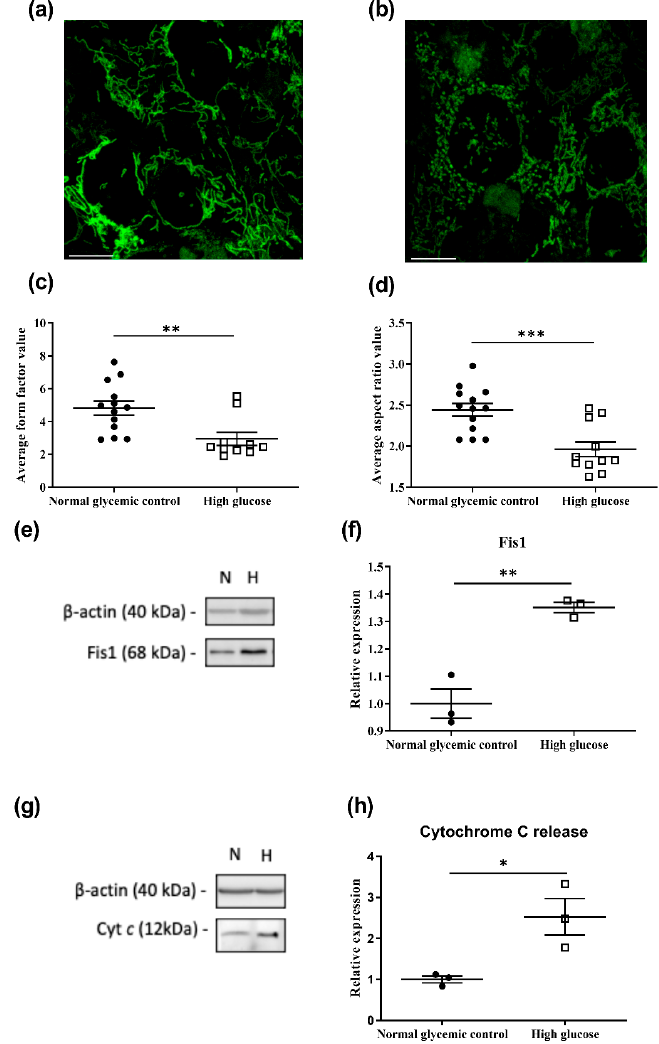
Figure 6. High-glucose-induced mitochondrial morphology changes and increased Fis1 levels and cytochrome c release in 661w cells. Representative confocal images showing mitochondrial mor- phology of 661w cells incubated in ( a ) the normal glycemic control and ( b ) high glucose. The scale bar represents 10 µm. Mitochondrial fragmentation was observed in 661w cells incubated with high glucose concentration. Graph showing the mean ( c ) form factor (FF) and ( d ) aspect ratio (AR) values for mitochondria of 661w cells after 48 h incubation in the two glucose concentrations. FF indicates the mitochondrial length and degree of mitochondrial branching. An FF value of one reflects a cir- cular, unbranched mitochondrion, whereas a higher FF value implies a longer, more branched mi- tochondrion. AR represents the circularity of a mitochondrion, with a value of one indicating a per- fect circle; the AR value increases with elongated and elliptical mitochondria. (** p < 0.01 *** p < 0.001; data presented as mean ± SEM. n ≥ 9 (biological replicates)). ( e ) Representative Western blot and ( f ) graphic illustration showing the Fis1 expression in 661w cells after normalization to the actin signal relative to the normal glycemic control. (** p < 0.01; data presented as mean ± SEM. n = 3 (biological replicates)). Cytochrome c translocation to the cytosol was assessed by Western blot anal- ysis after subcellular fractionation. Cytosolic protein fractions were isolated from 661w cells after 48 h incubation under normal glycemic control and high-glucose conditions. ( g ) Representative image of Western blot analysis. ( h ) Graphic illustration showing the relative change in cytochrome c levels in the cytosol of 661w cells under high glucose after normalization to the actin signal (* p < 0.05; data presented as mean ± SEM. n = 3 (biological replicates) for each condition).